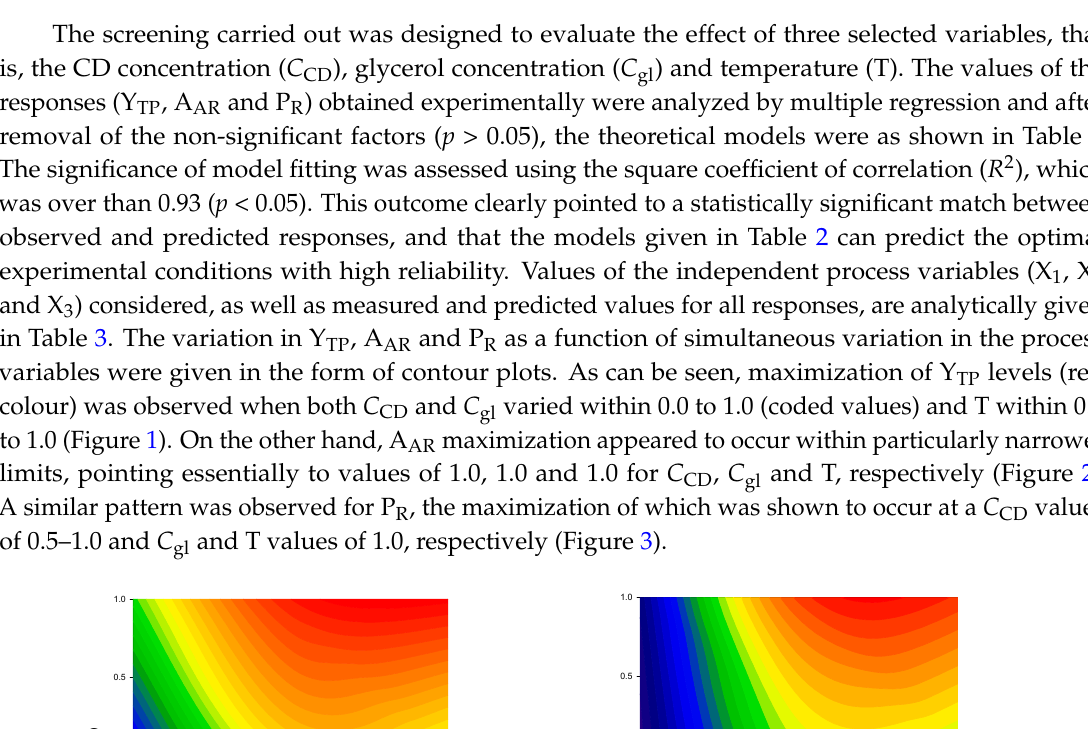
Table 1. Experimental values and coded levels of the independent variables used for the 2 3 full-factorial